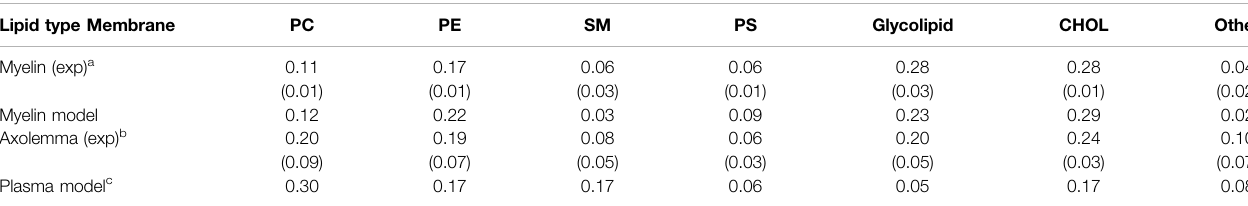
TABLE 1 | Experimental and modelled lipid composition in weight fraction for different types of membrane. Lipid type